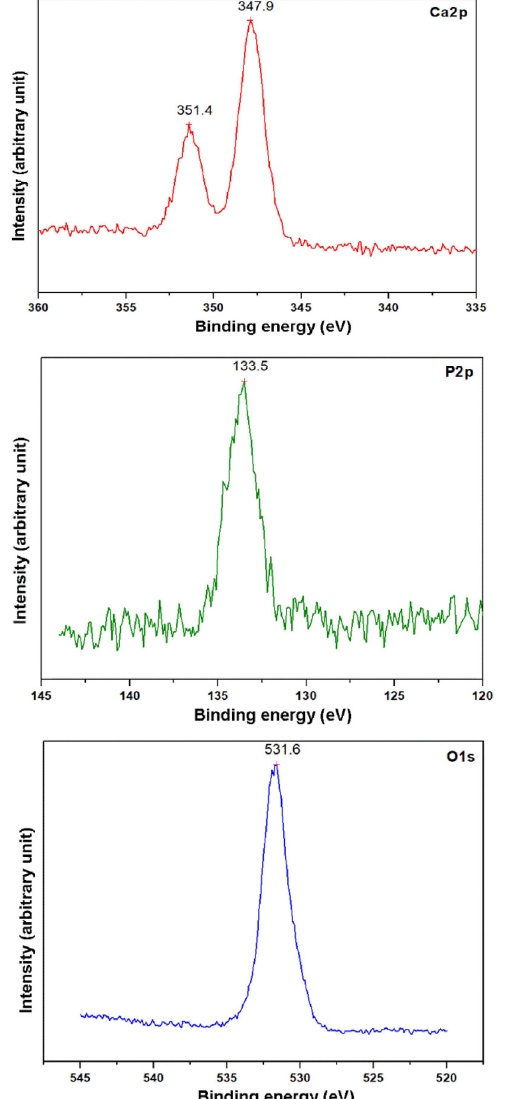
Fig. 11 Ca2p, P2p, and O1s XPS narrow spectra of ATF-C tribofilm.